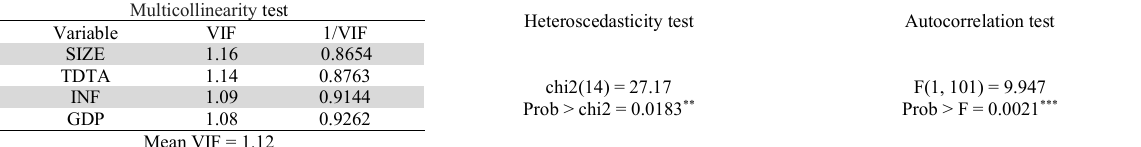
Results of VIF, heteroscedasticity and autocorrelation tests (Model 1)